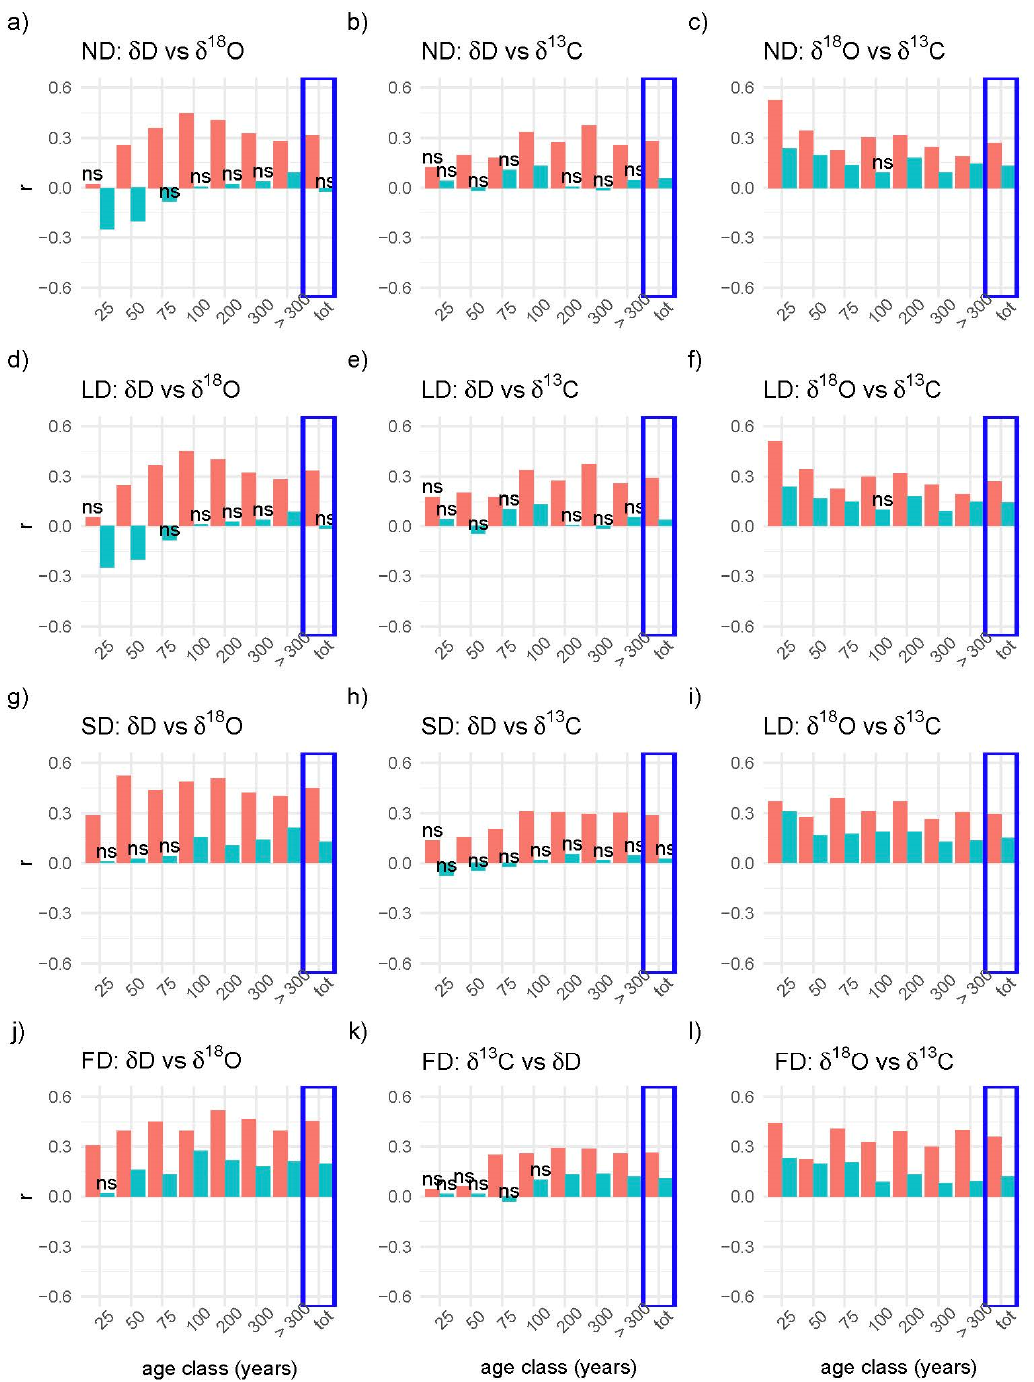
Figure 3. Correlations between the stable isotopes. The correlations were calculated using the Spearman method in larch (red) and cembran pine (turquoise) in each age class (1–25, 26–50, 51–75, 76–100, 101–200, 201–300, >300 years) and also with the total data of each species (blue box). Correlation r values are displayed as histograms and “ns” on the column indicates non-significant correlation ( p -value > 0.05). The values of larch trees are in red, those of cembran pine are in turquoise. The plots are presented in the same order of Figure 2. The upper ND shows the correlations of non-detrended values ( a – c ), the LD below are those of linear detrended values ( d – f ), then are the SD plots of spline detrended ( g – i ), and the lowest FD plots are those after first-difference time-series detrending ( j – l ).